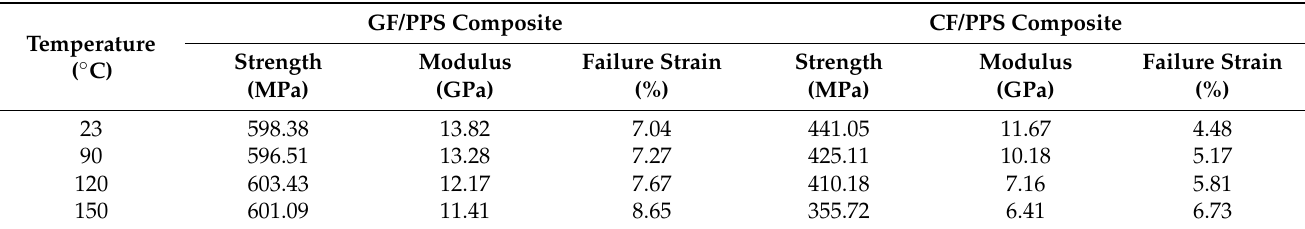
Table 3. Dynamic compression properties for GF/PPS and GF/PPS composites at different temperatures. Temperature